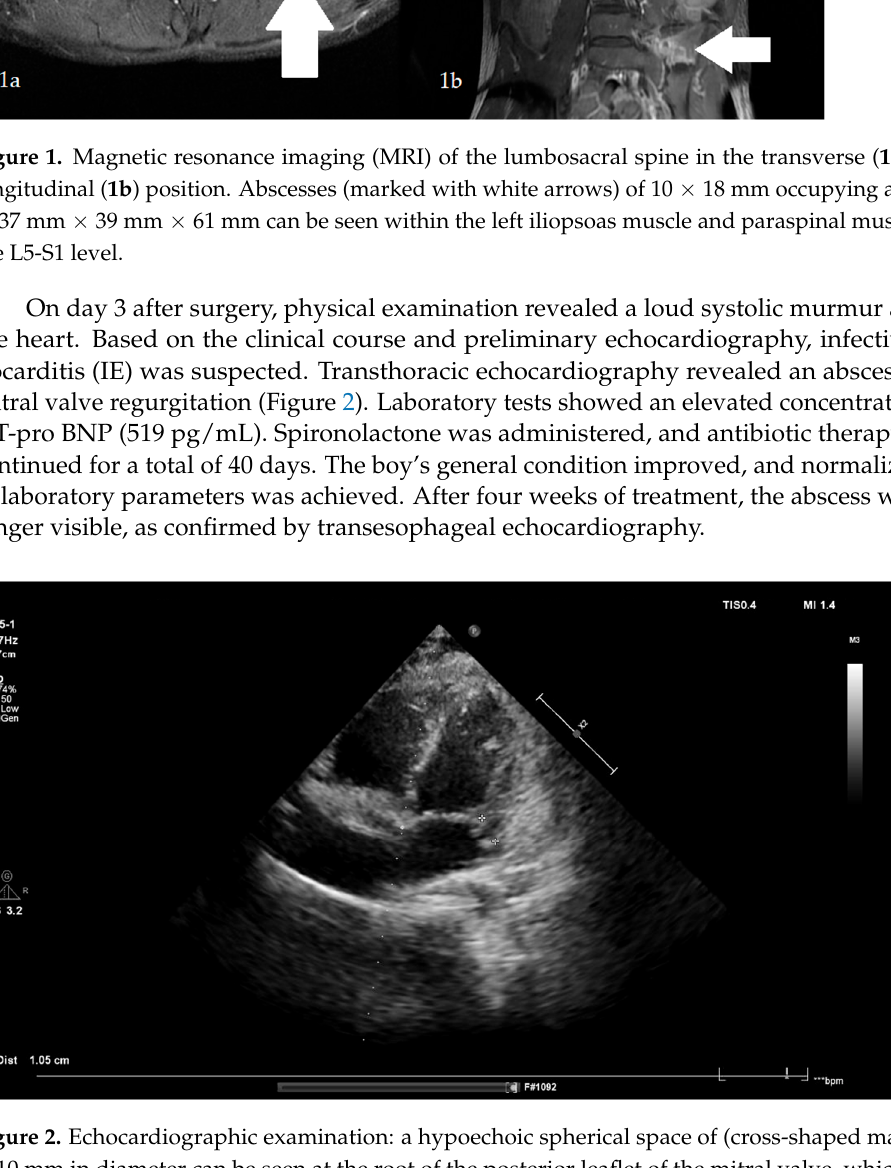
Figure 2. Echocardiographic examination: a hypoechoic spherical space of 9–10 mm in diameter can be seen at the root of the posterior leaflet of the mitral valve, which may correspond with an abscess. (cross-shaped markers) Moderate mitral regurgitation 8–9 mm can also be observed, reaching the apex of the left atrium. The patient was discharged to home in good general condition. During the follow- up a slight mitral regurgitation, but no abscesses in the area of the spine or pelvis in MRI, were found.